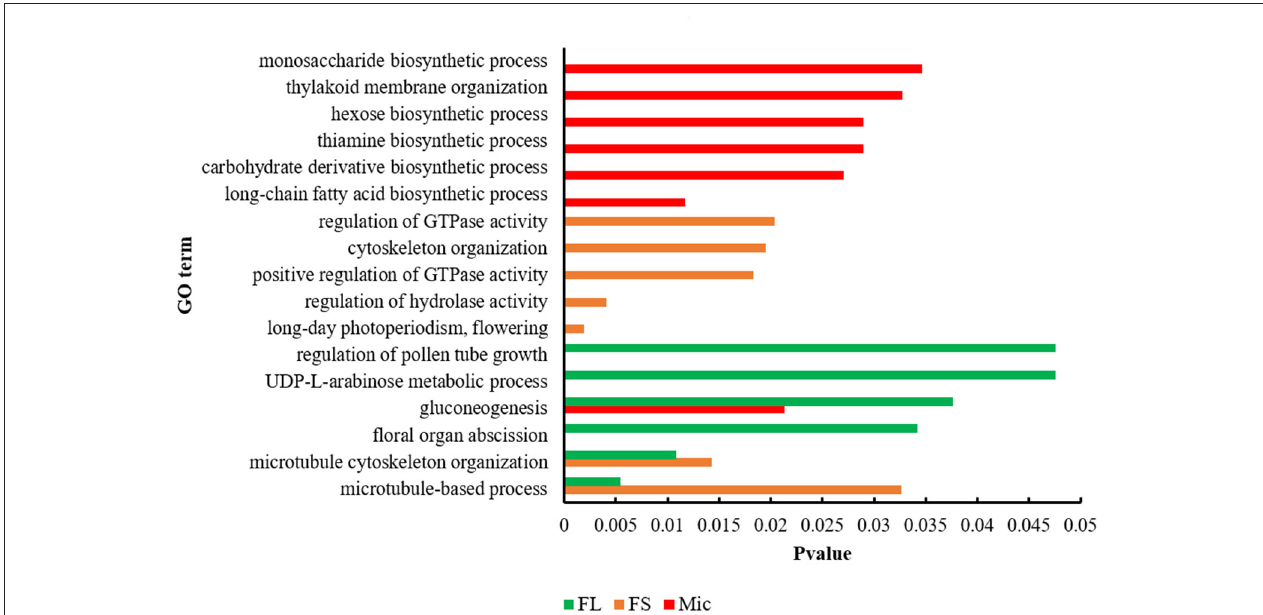
FIGURE 3 | Function characterization of candidate genes associated with three fiber quality traits by Gene Ontology (GO) analysis. FL, fiber length; FS, fiber strength; Mic, fiber micronaire.